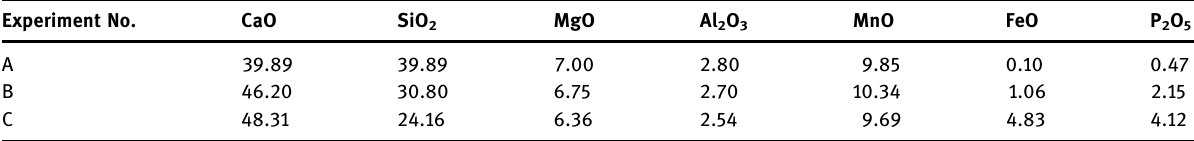
Table 3: Chemical compositions of the reduced slag after experiments ( mass fraction, % ) Experiment